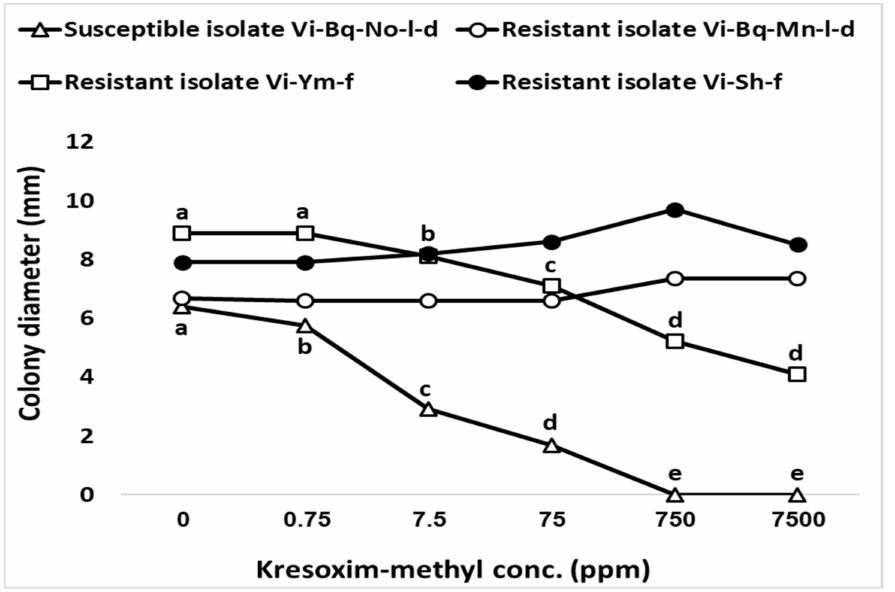
Figure 8. Activity of different concentrations of kresoxim-methyl on mycelial growth of susceptible (V.i-Bq-No-l-d) and three resistant (V.i-Bq-Mn-l-d, Vi-Ym-f and Vi-Sh-f) isolates. Colony diameters were recorded on day 14 post-inoculation. Different letters for isolates V.i-Bq-No-l-d and Vi-Ym-f indicate significant differences ( p < 0.05) according to Fisher’s LSD K-ratio t